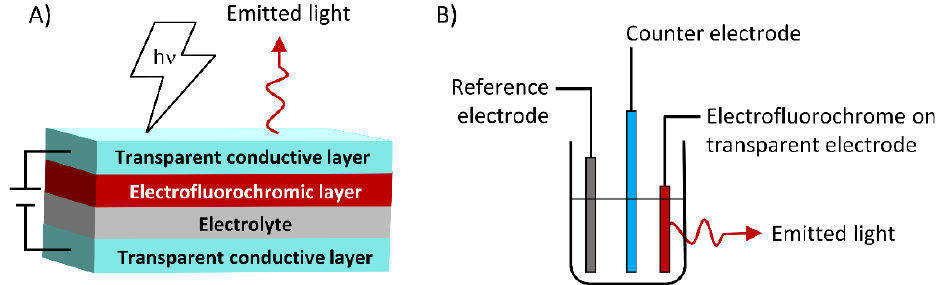
Figure 1. Different types of EFC devices used to evaluate the performance of EFC materials: ( A ) full device and ( B ) half ‐ device.